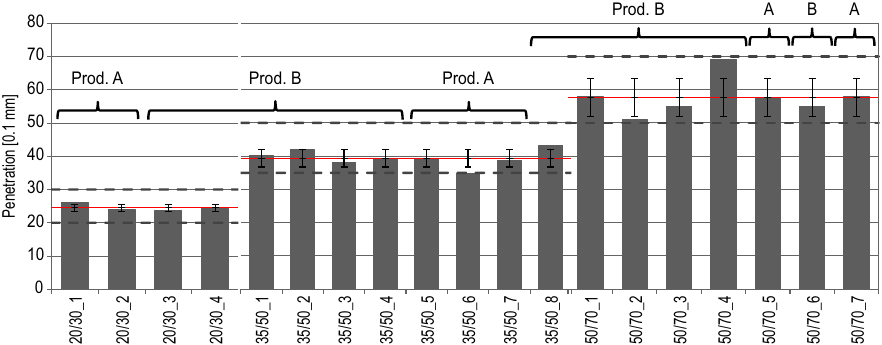
Fig. 1. Unmodified bitumen penetration at 25